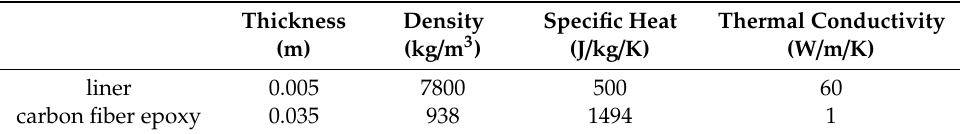
Table 3. GASVESSEL project: CNG vessel wall properties [4].